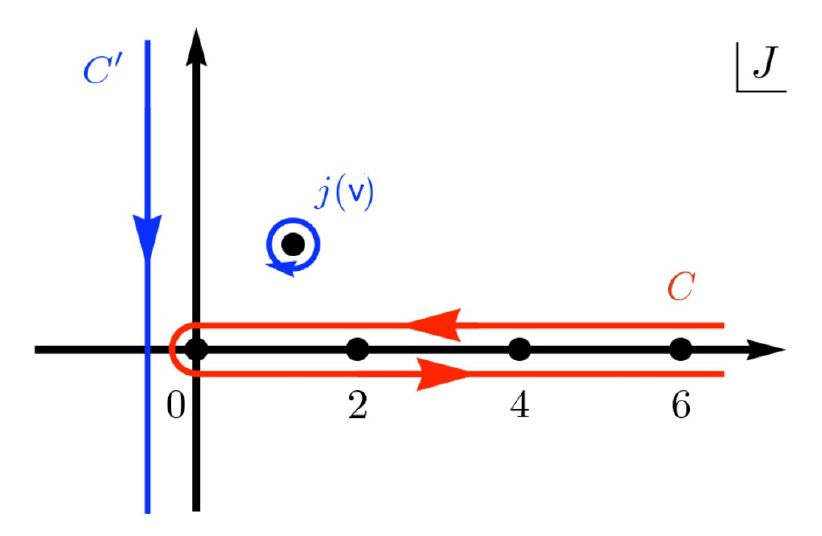
Figure 3 . Contour Deformation. We switch from the sum over spins J to a contour integral. We then deform the contour and pick the contribution from a singularity with the maximal Re[ J ], which we assume to be a